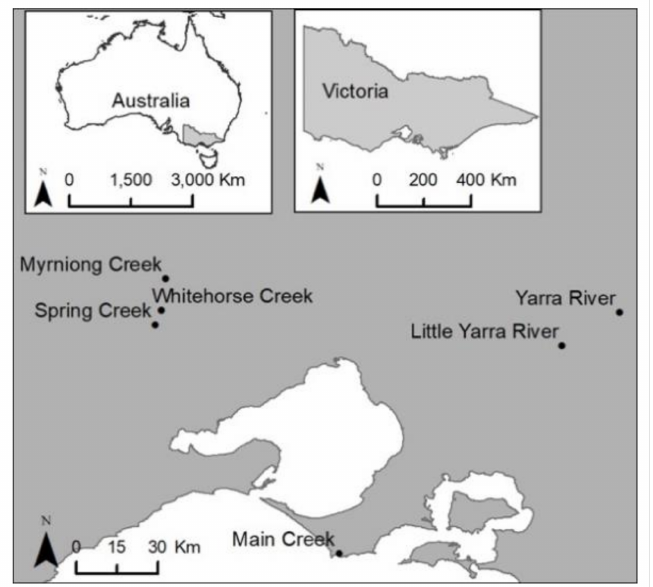
Figure 1. Map of the six study sites, showing the location of the state of in south-eastern Australia ( top left ), the state of Victoria ( top right ), and the six study locations ( bottom